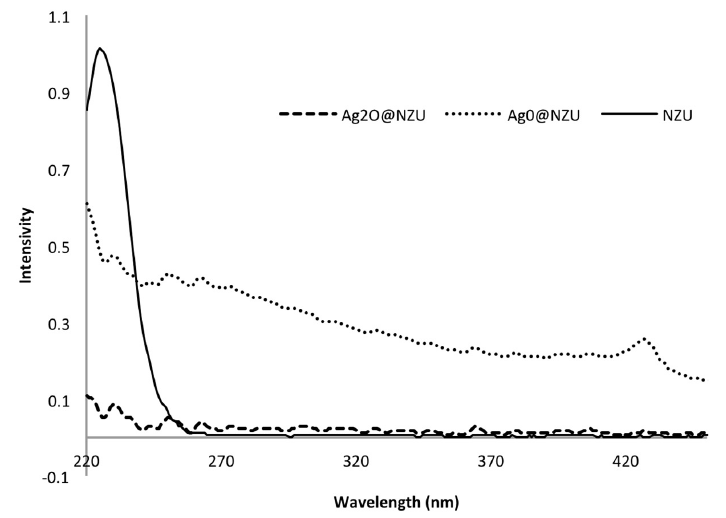
Figure 13. UV ‐ Vis scan after 72 h of adsorption at 200 ppm iodide. Figure 13. UV-Vis scan after 72 h of adsorption at 200 ppm